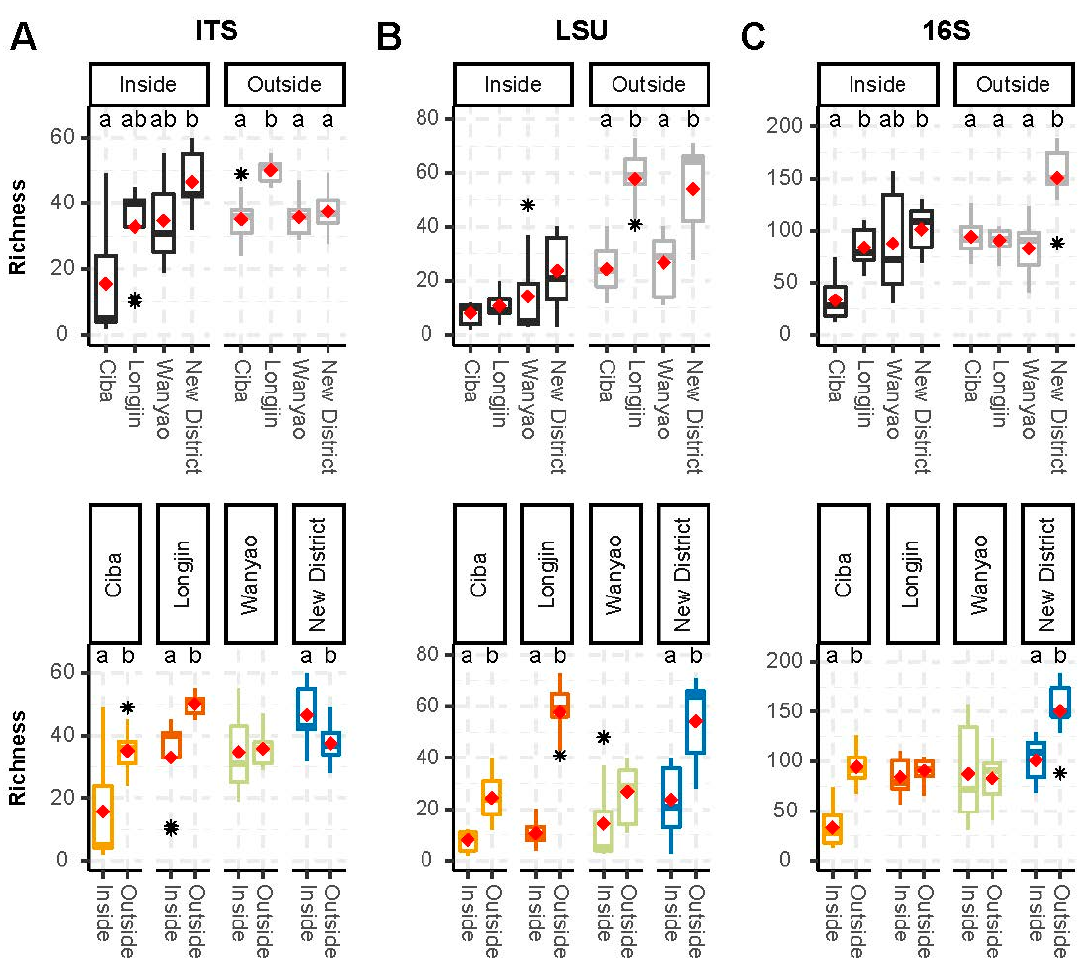
Figure 1. Boxplot of observed species richness for ITS ( A ), LSU ( B ), and 16S ( C ) rDNA markers data sets microbial communities. Data are shown for the niche sampled (inside vs. outside of the tofu sample) for each of the four markets sampled. Red diamonds represent the mean of the distribution. Letters, when present, represent pairwise Wilcoxon tests among groups after a Kruskal–Wallis test ( p ≤ 0.05 after Bonferroni adjustment). Outliers are marked with an asterisk (*).